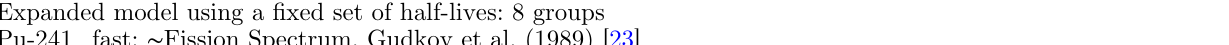
Table 13. Relative abundances and half-life of delayed neutrons (8-group DN data set) for fast neutron induced fi ssion of 241 Pu. Expanded model using a fi xed set of half-lives: 8 groups Pu-241_fast: ∼ Fission Spectrum. Gudkov et al. (1989) [23] Gr. No. i